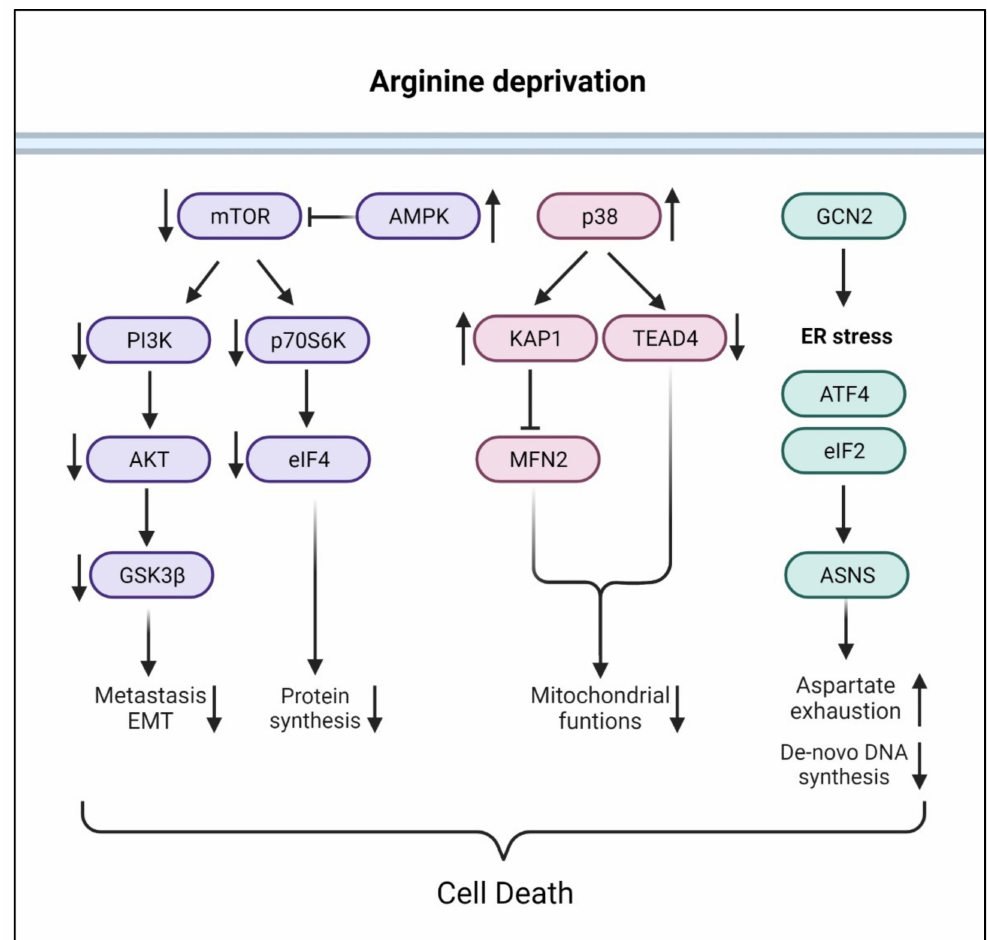
Figure 3. Arginine deprivation signaling pathways. In contrast to arginine stimulation, arginine deprivation suppresses mTOR pathway via activation of AMPK. Additionally, arginine deprivation induces p38-signaling pathway, which impairs mitochondria functions. Arginine deprivation also can induce ER stress via GCN2, resulting in aspartate exhaustion and decreased DNA